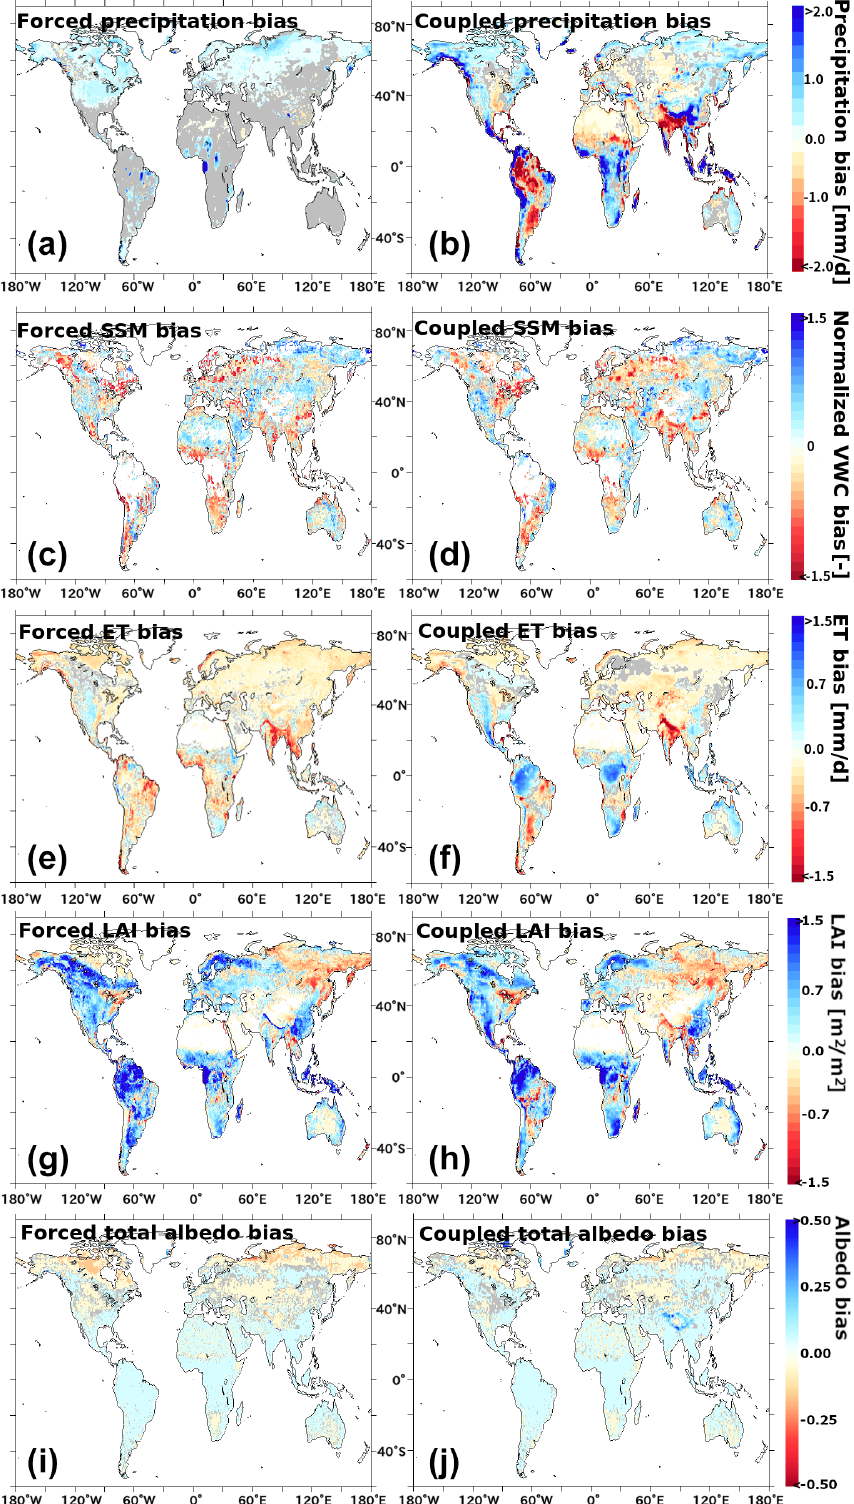
Figure 2. Pluriannual average of bias (i.e., simulated values minus observed values) for the five evaluated variables simulated in forced mode (left) and coupled mode (right). (a, b) Precipitation bias against GPCC. (c, d) SSM bias against CCI-SSM, in normalized volumetric water (VWC) content during period 1 (1993–1999). (e, f) ET bias against upscaled FLUXNET data. (g, h) LAI bias against LAI3g data. (i, j) Total albedo bias against MODIS albedo product. Gray areas are statistically insignificant